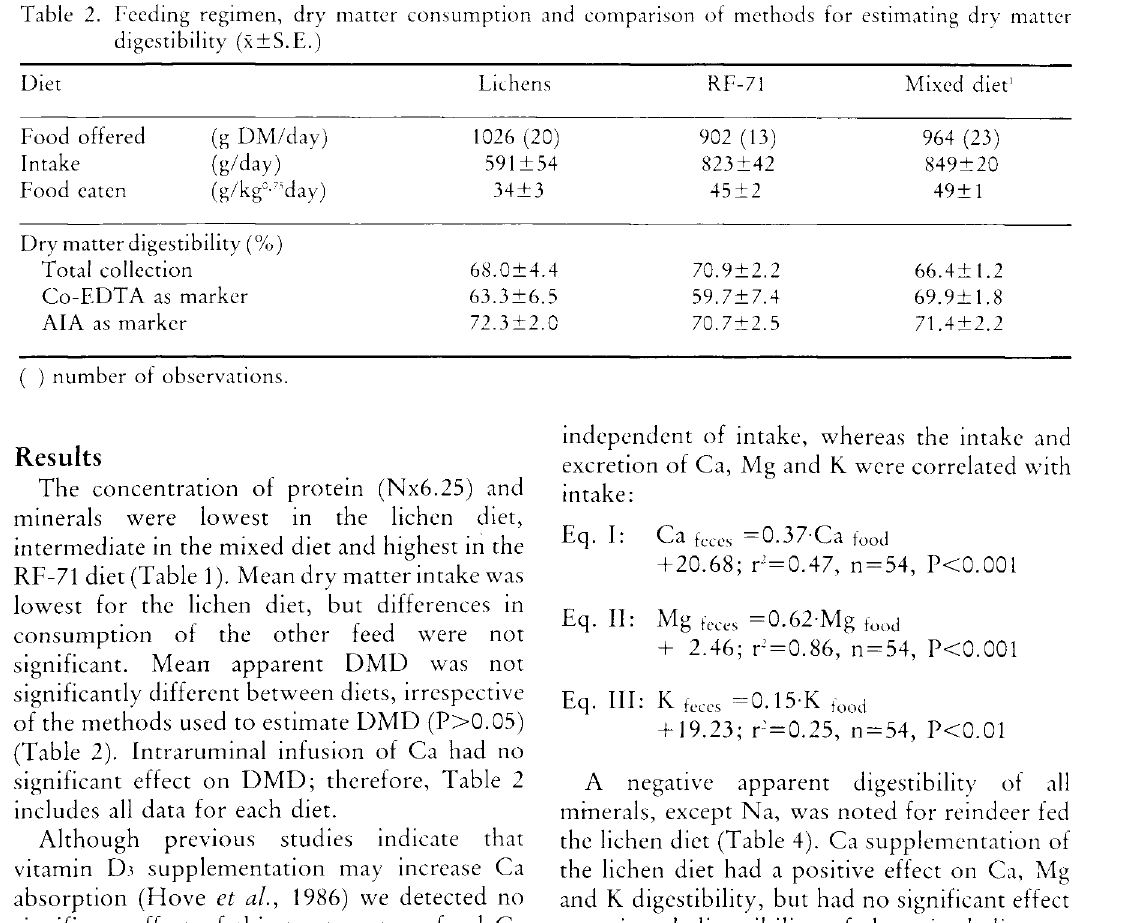
Table 3. The effects of dietary Ca supplementation of fecal mineral concentration (mM/kg DM) and water content (g/100 g wet weight)